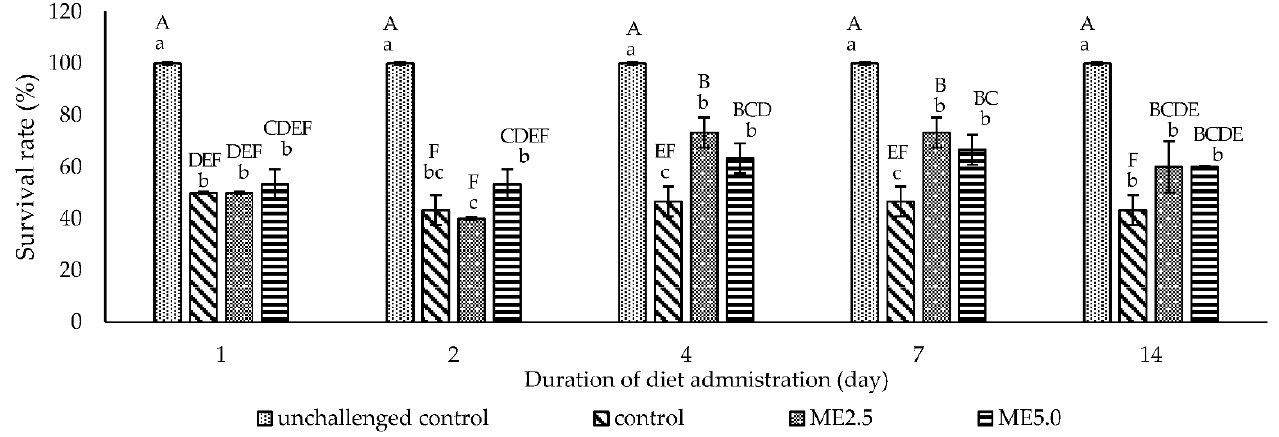
Figure 7. Cumulative survival rate at 72 h after challenge for all the different durations of diet administration (1, 2, 4, 7, and 14 days). The data are expressed as the mean ± standard deviation ( n = 3). Bars with different lowercase letters (a–c) are significantly different ( p < 0.05) at the same time point. Bars with different uppercase letters (A–F) are significantly different ( p < 0.05) for all time points.